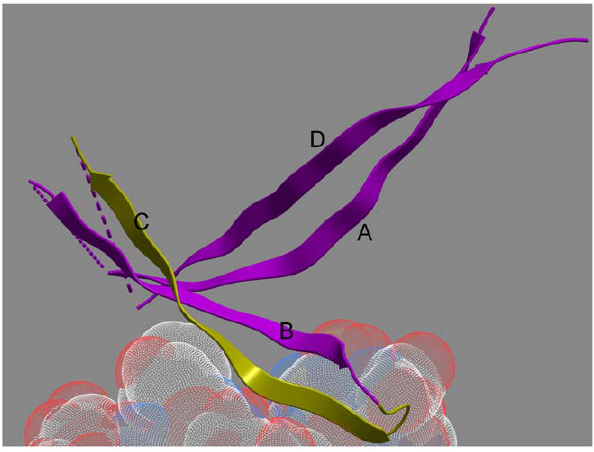
Figure 6. Ribbon diagram of the backbone fold of the V1V2 domain (purple and yellow ribbons) bound to the CDR H3 region of mAb PG9 (transparent stippled spheres are the atoms of the PG9 CDR H3, blue=nitrogen, red=oxygen, white=carbon). The ribbon backbone of AAs 165–176, which are identical to Peptide 6 (in Figure 5 ), is colored yellow. The strands are labeled A–D according to the convention established recently [28].